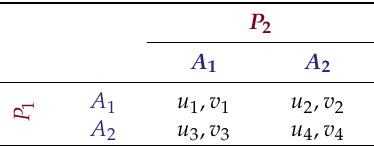
Table 1. Two players matrix